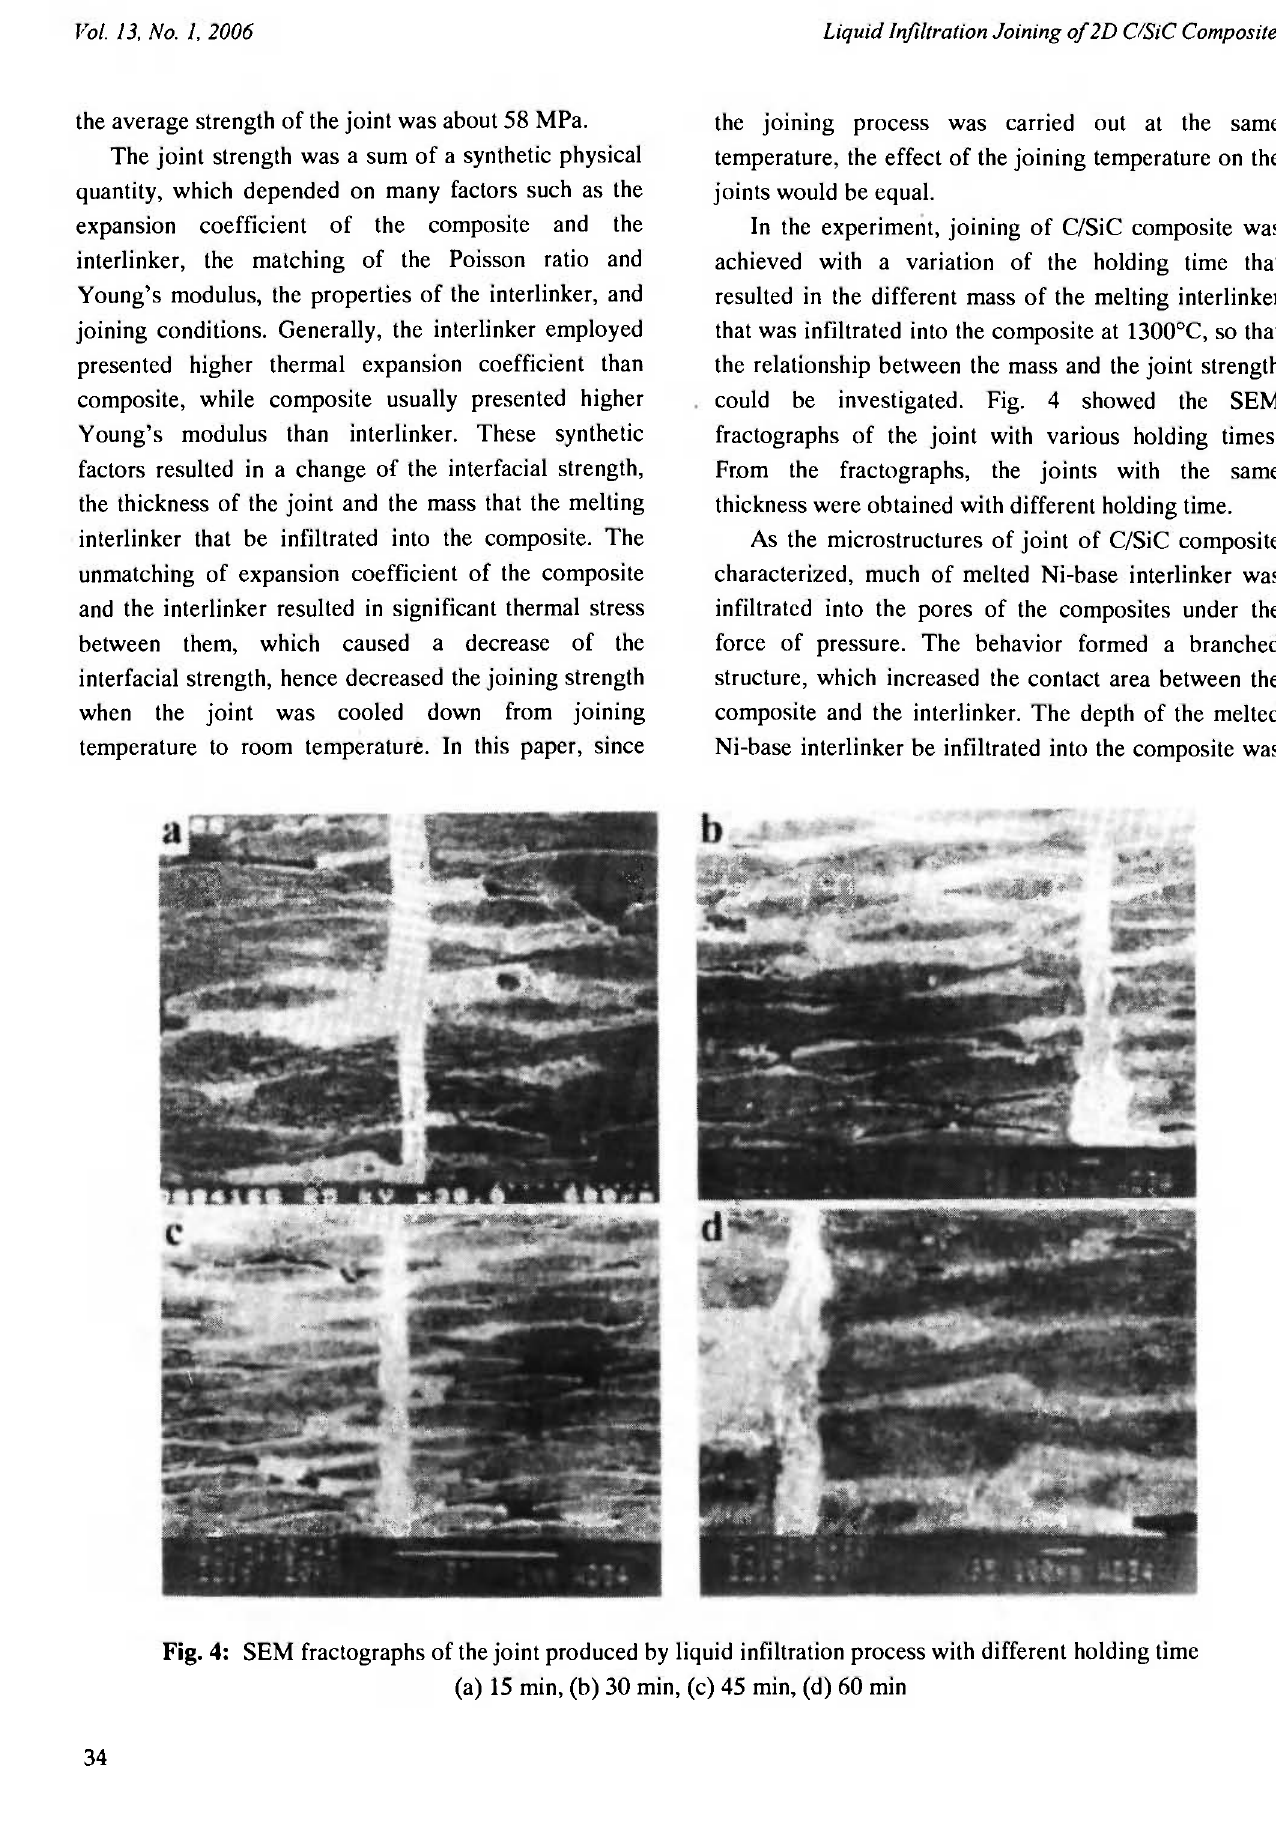
Fig. 4: SEM fractographs of the joint produced by liquid infiltration process with different holding